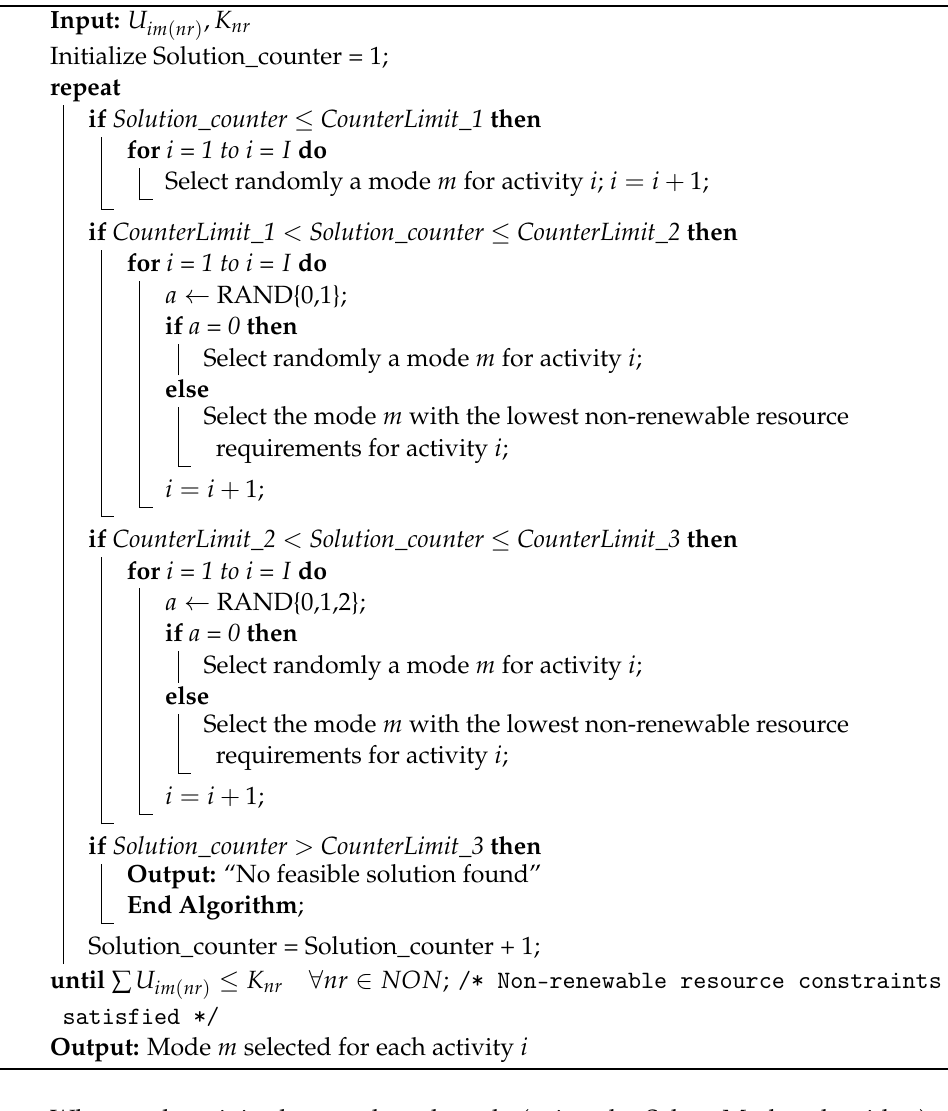
Algorithm 1: Select_Modes. Algorithm for the selection of